Question: Author a descriptive caption for the visualization shown.
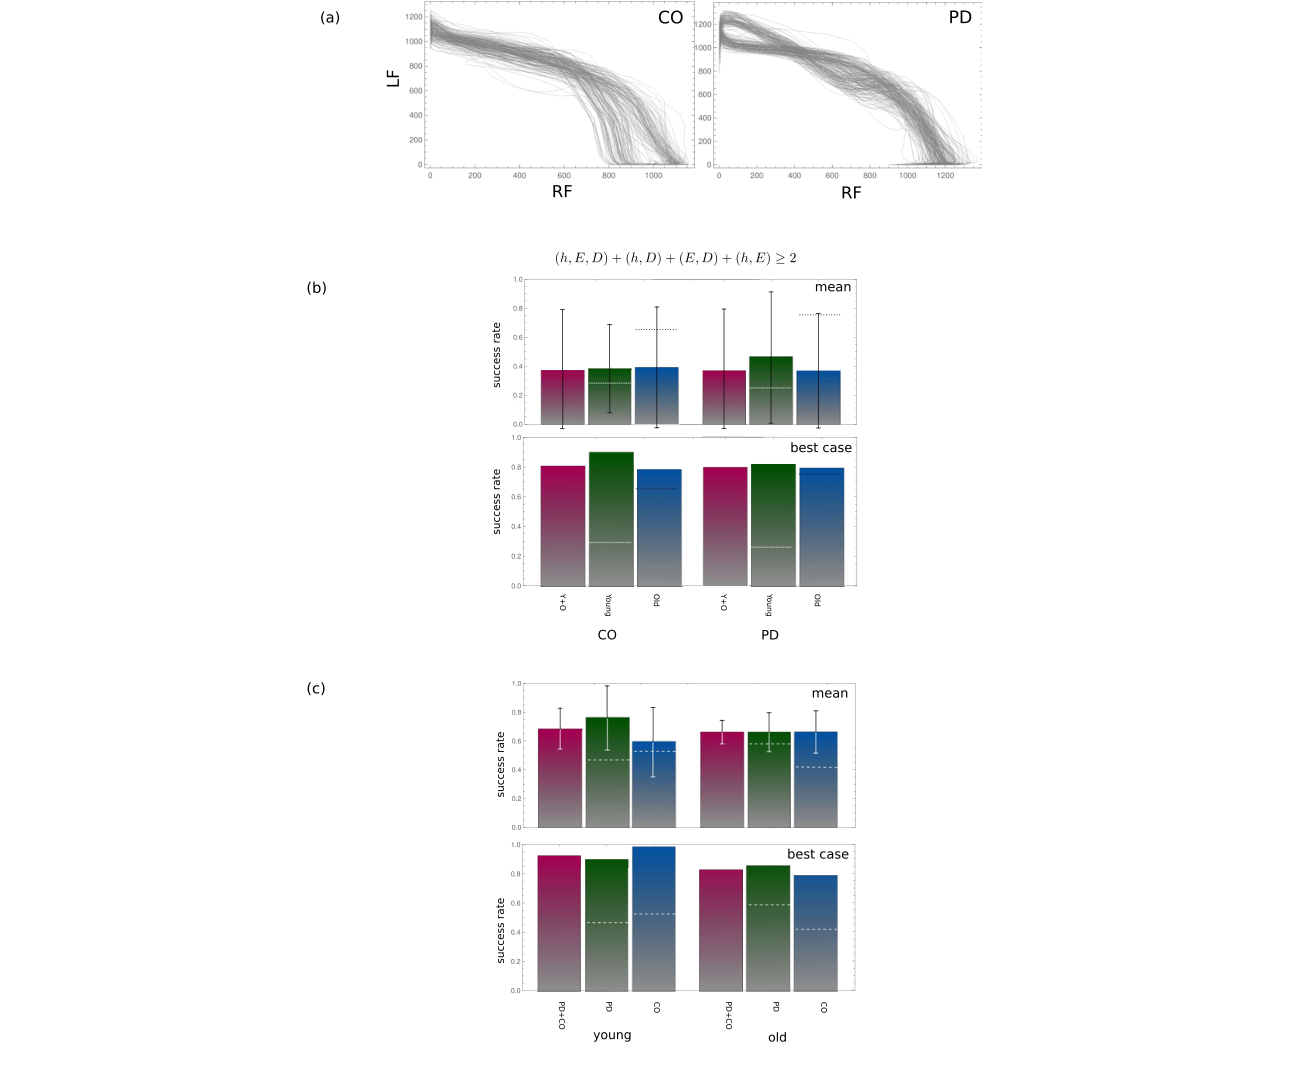
Answer: Parkinson’s disease analysis through gait measurements. Pressure in both feet was recorded as a function of time and taken as a trajectory. (a) Shows the plot of two trajectories, one for a control healthy subject (CO) and one for a subject with Parkinson’s disease (PD). RF and LF refers to right and left foot, respectively. Subjects are walking at a normal pace for two minutes. Subject trajectories were discretized using Freeman coding and entropic analysis, and estimating the entropy density (h), eﬀective measure complexity (E), and fractal dimension (D) was performed. From the entropic data, the classiﬁcation of subjects into young and old was attempted (b). In order to perform the classiﬁcation, the entropic magnitude was used on a neural network. The subjects were divided into two subsets: one for training, with the same number of young subjects and old patients, and a second subset for the classiﬁcation trial. This was repeated 100 times, choosing the training and trial s